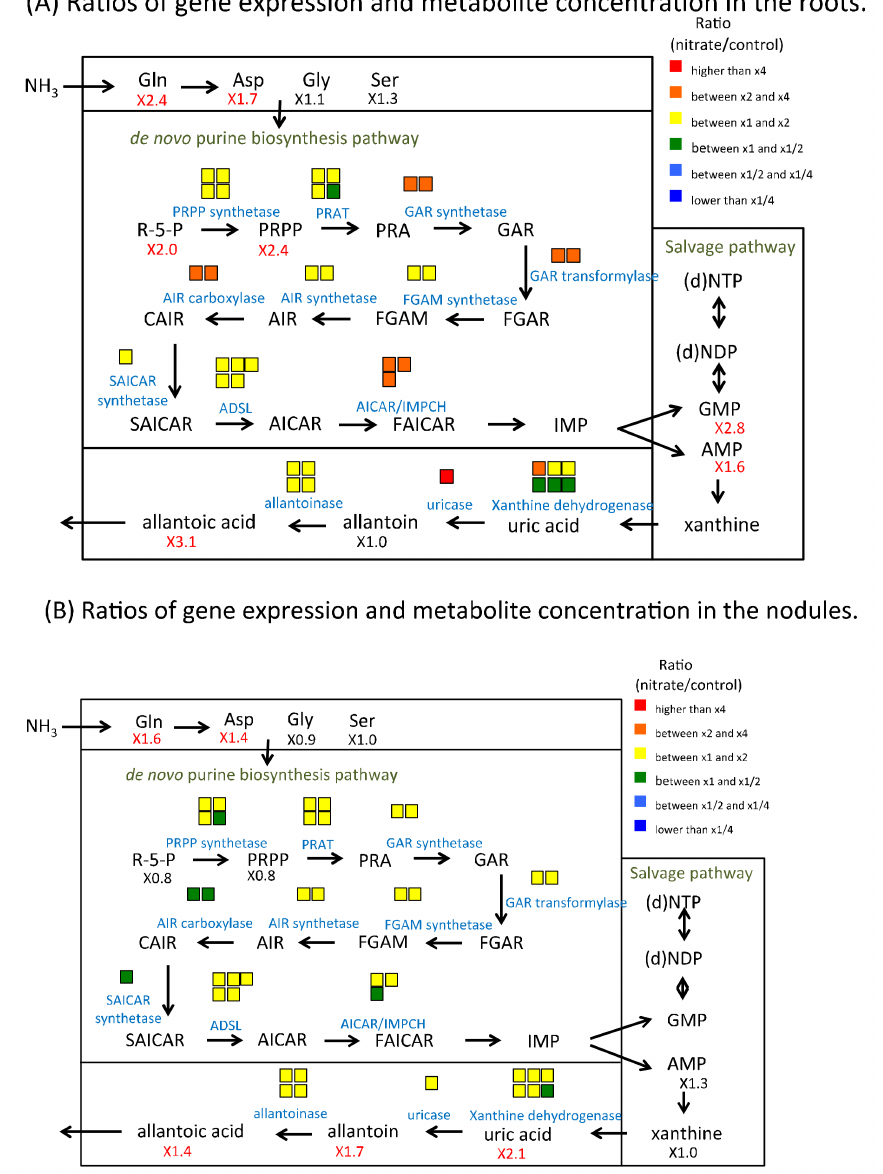
Figure 4. Ratios of gene expression related to ureide synthesis in soybean roots and nodules after 24 h of the 5-mM nitrate treatment. ( A ) Ratios of gene expression and metabolite concentrations in the roots. ( B ) Ratios of gene expression and metabolite concentrations in the nodules. The model shows the metabolic map of ureide synthesis in the root or nodule cells. The color of squares above enzyme name and the number under the compound abbreviation indicate the same as Figure